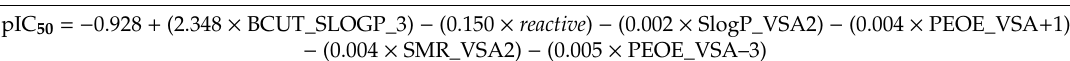
Table 2. Two-dimensional quantitative structure–activity relationship models (2D-QSAR) for AChE and BACE-1 inhibitors reported in the previous published work [37]. AChE